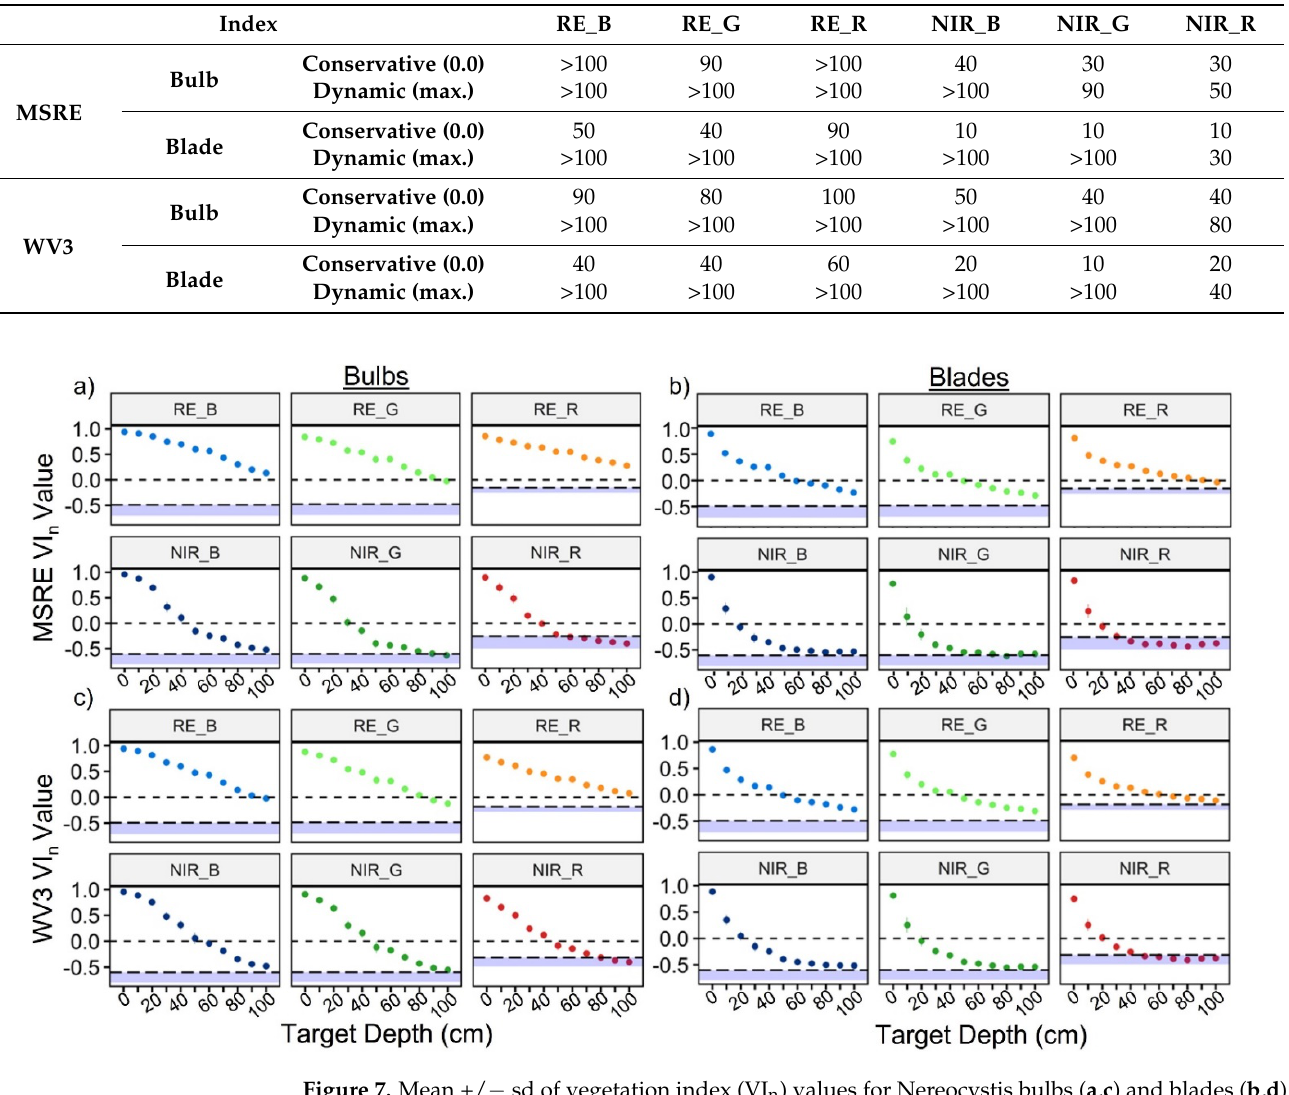
Figure 7. Mean +/ − sd of vegetation index (VI n ) values for Nereocystis bulbs ( a , c ) and blades ( b , d ) submerged from the surface to 100 cm. derived from simulated Micasense RedEdge-MX (MSRE; a , b ) and WorldView-3 (WV3; c , d ) bandwidths. The black dashed lines at 0 represent the more conservative and realistic threshold, and the blue bars represent the full range of water values for each respective index, with the adjacent dashed lines representing the dynamic threshold. Table 5. Depth detection limits (cm) based on conservative threshold of 0.0 and the dynamic thresh- olds (maximum water value) for Nereocystis bulbs and blades, as simulated to Micasense RedEdge- MX (MSRE) and WorldView-3 (WV3) bandwidths.